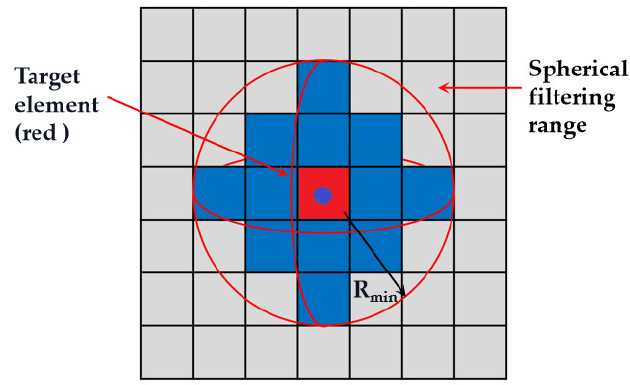
Figure 1. Schematic diagram of sensitivity